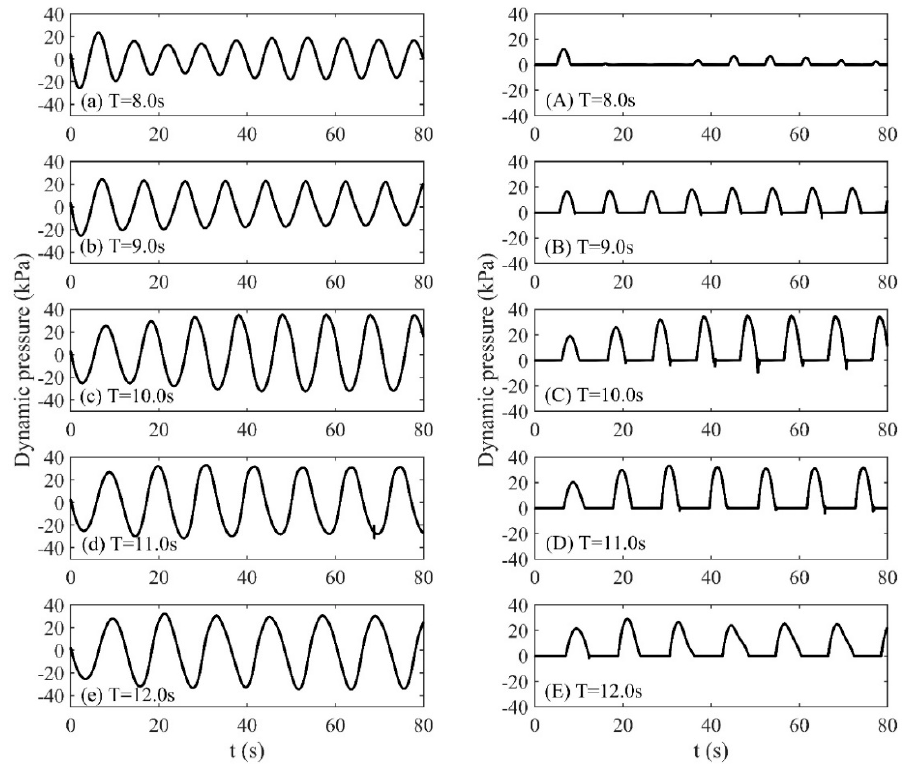
Figure 7. Comparisons of dynamic pressures among various forcing periods 8.0 s, 9.0 s, 10.0 s, 11.0 s and 12.0 s at P2 ( left column ) and P4 ( right column ).